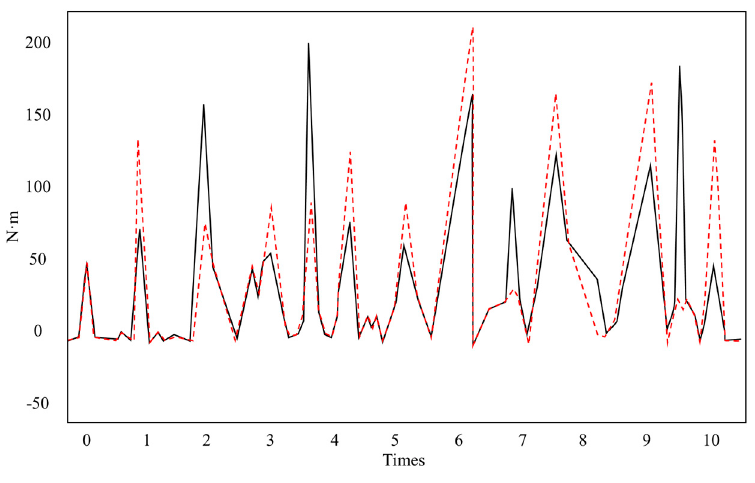
Figure 8. Driving moment curves of the hip and knee joints of the right hind leg.